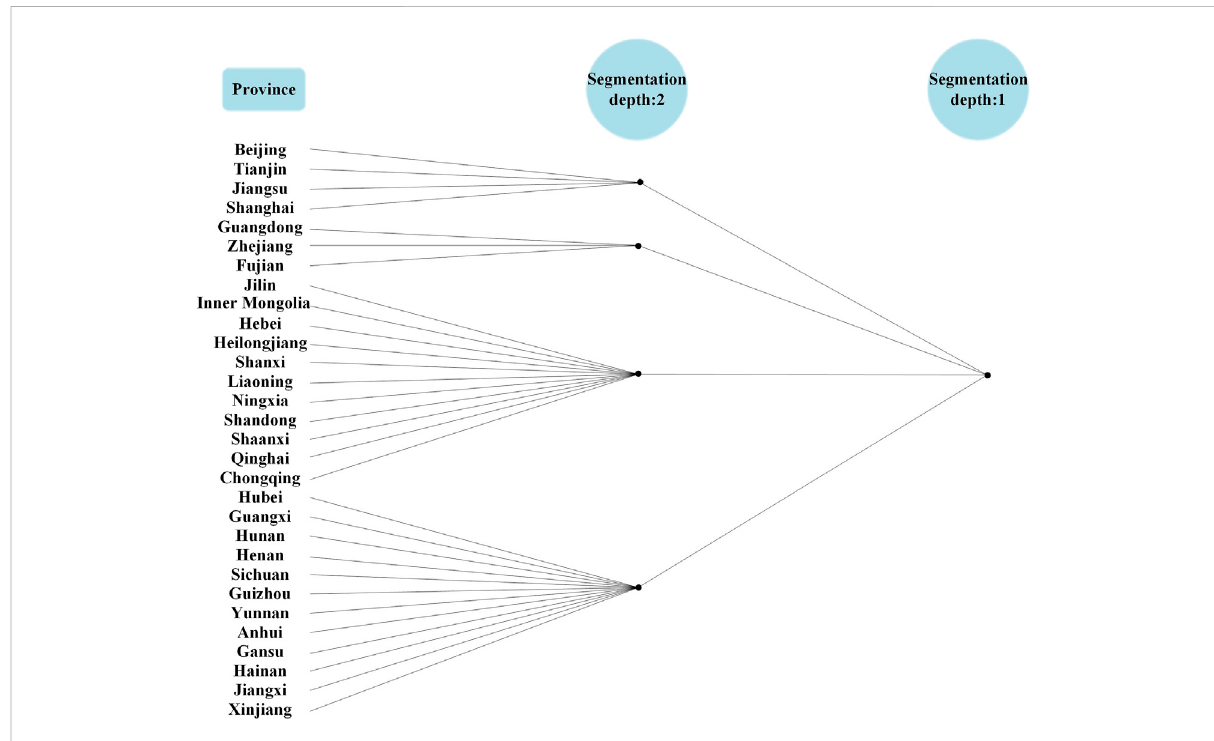
FIGURE 7 Spatial aggregation result of GTFP in